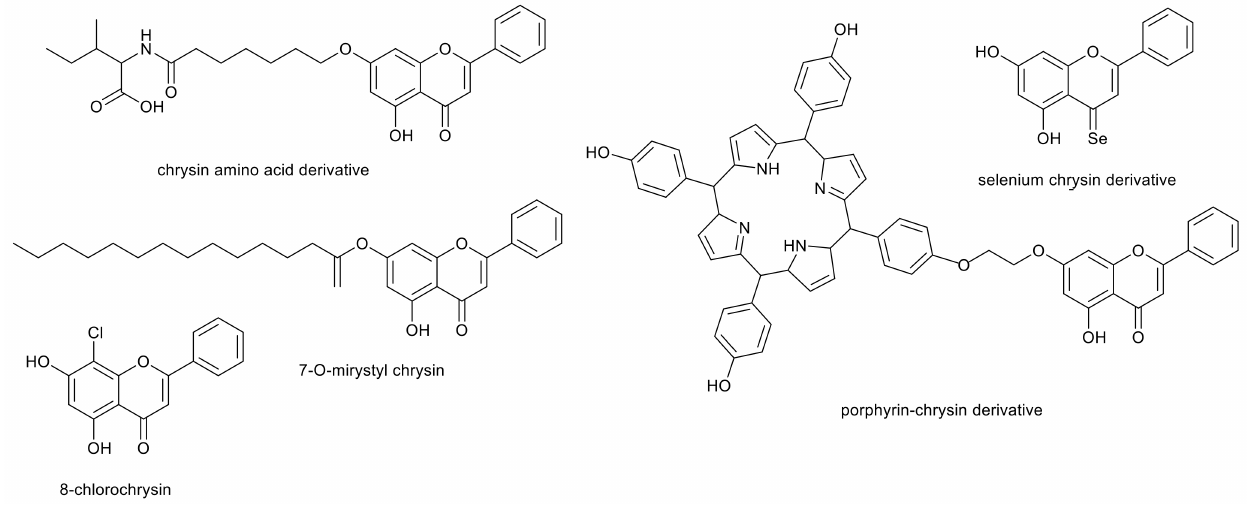
Figure 4. Examples of chrysin derivatives with proven anticancer